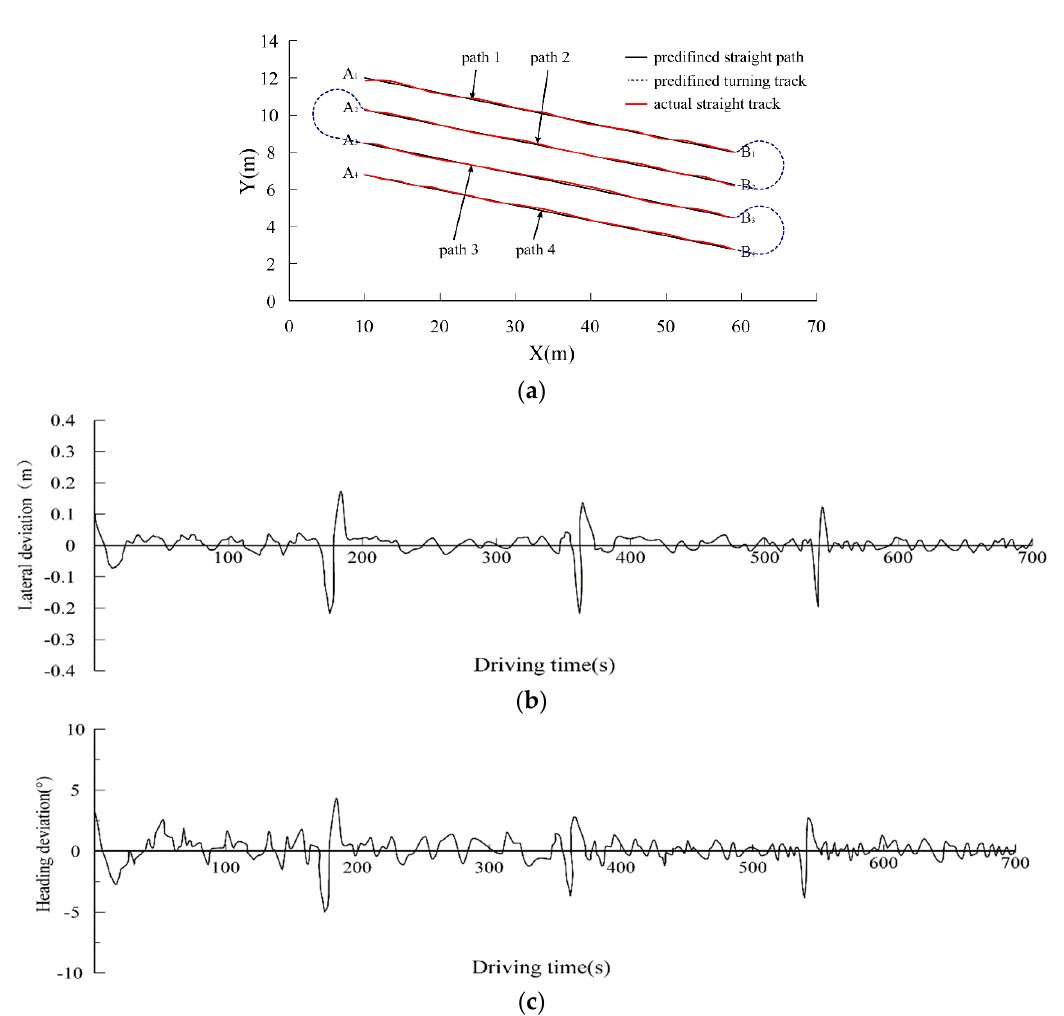
Figure 10. Straight tracking results: ( a ) Straight track; ( b ) lateral deviation curve; ( c ) heading deviation curve.